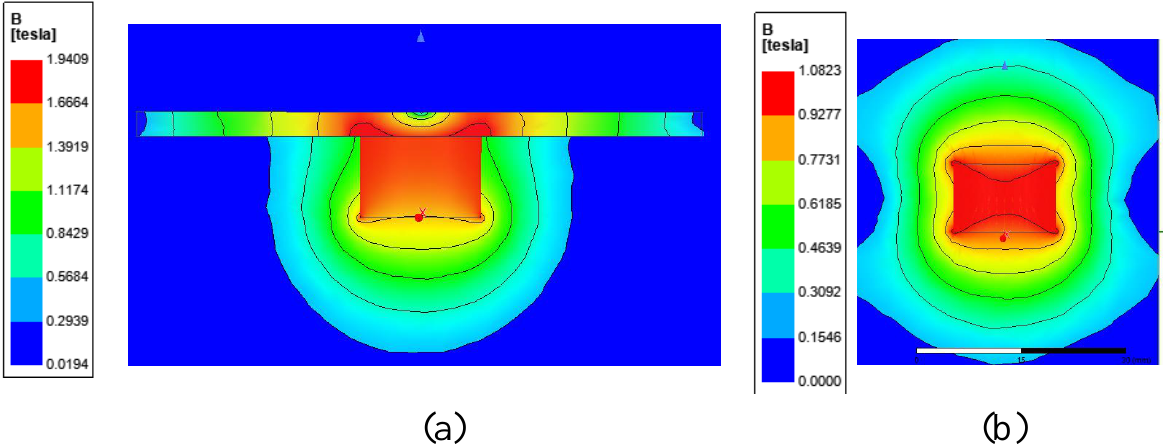
Figure 5. ( a ) Magnetic flux density of the FMM tool in the presence of the reactive part as a magnetic shield; ( b ) magnetic flux density of the FMM tool after total removal of the shield (reactive part) by corrosion.